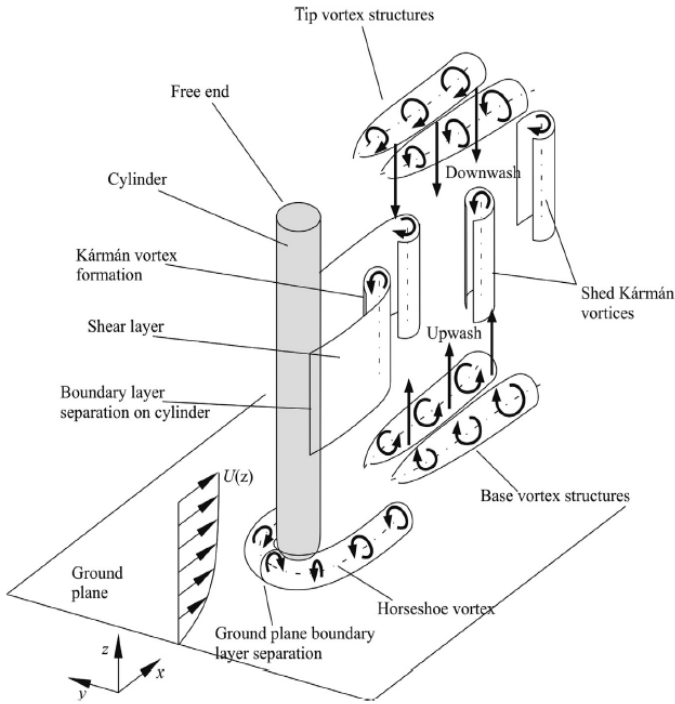
Figure 1. Schematic diagram of the flow field for finite circular cylinders greater than the critical aspect ratio. (Reproduced with permission from [18], published by Elsevier 2013.)